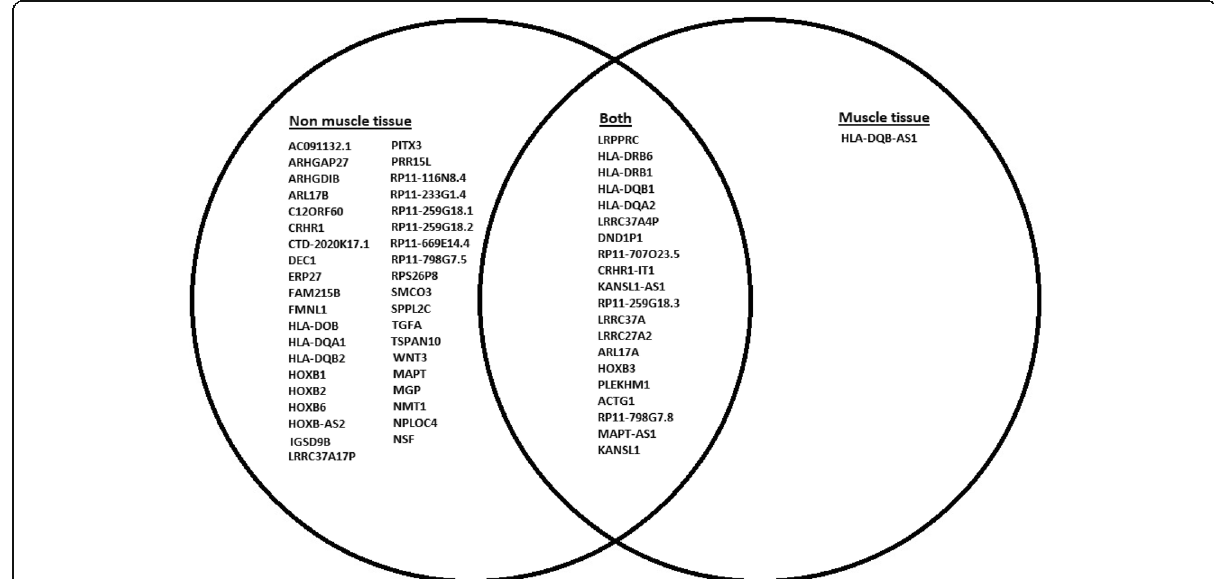
Fig. 3 Gene expression based on Handgrip GWAS data and GTEx eQTL enrichment analysis